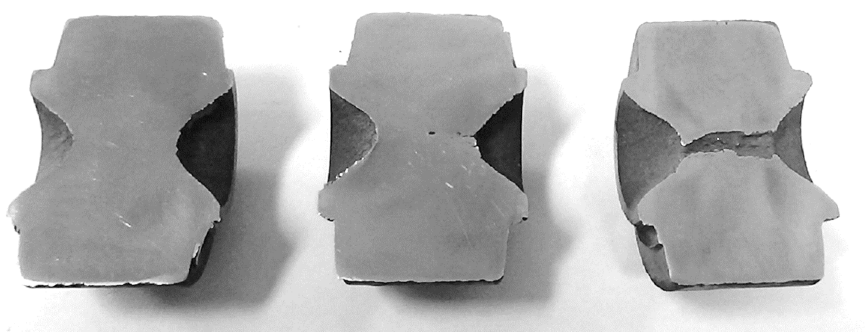
Figure 10. Samples heated to 1150 °C and compressed rotationally in a channel on the path s equal (respectively from the left): 700 mm, 750 mm and 800 mm.